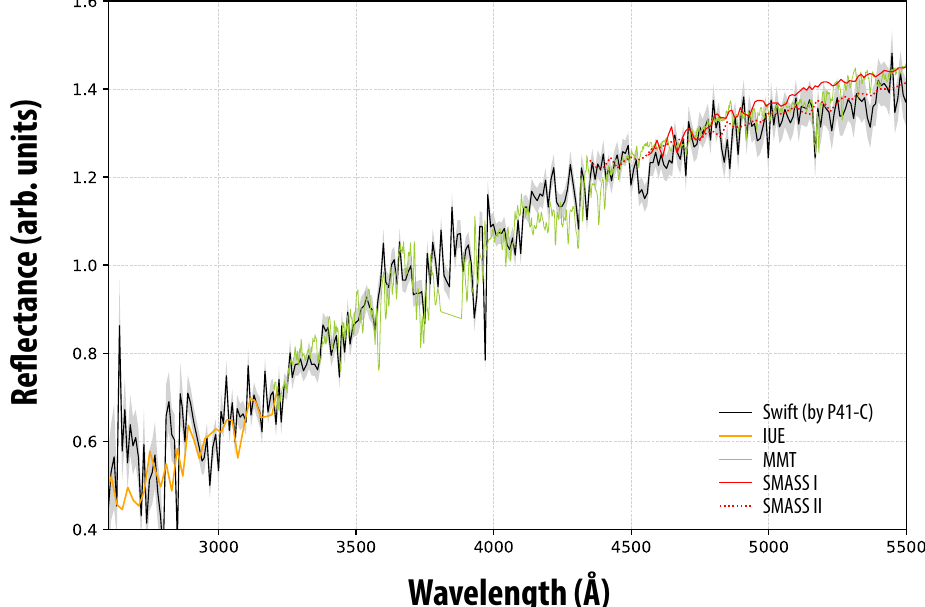
Figure 7. Reflectance spectra of asteroid (3) Juno. The black curve is the reflectance spectrum observed by Swift /UVOT, normalized around 3800 Å. The shaded area around the spectrum marks the 1- σ uncertainties. The orange curve is the IUE reflectance spectrum [63], which is scaled to more clearly compare with the UVOT spectrum. The green curve is the scaled reflectance spectrum measured with the MMT 6m telescope [60]. The scaled red solid curve and the scaled red dotted curve were respectively measured by SMASS I [68] and SMASS II surveys